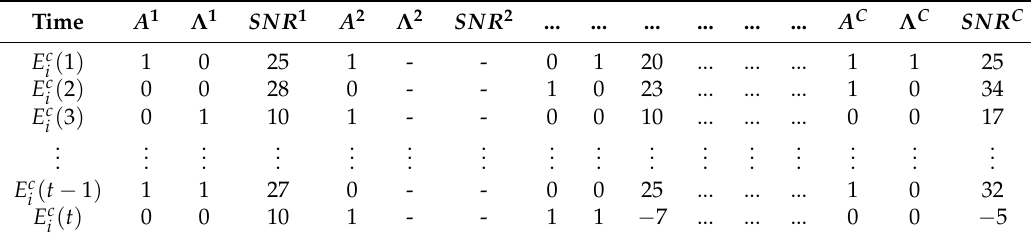
Table 3. Illustration of the sensing table in SU i . Legend: 1, Inactive; 0,